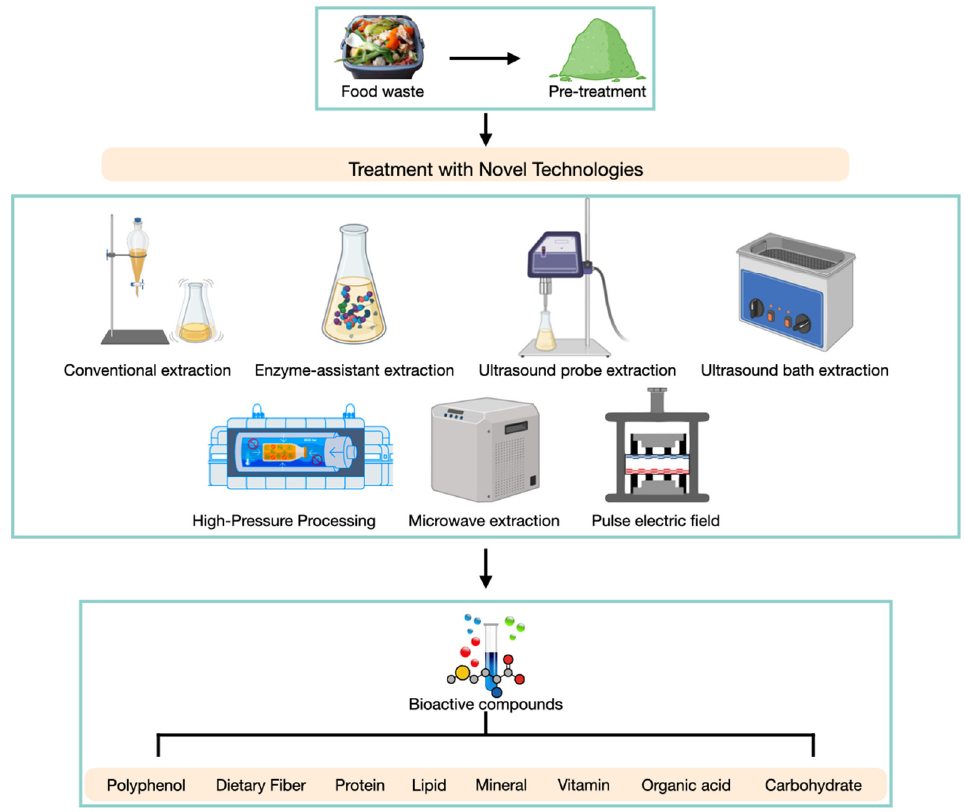
Figure 3. Extraction of bioactive substances from food waste using various novel methods.